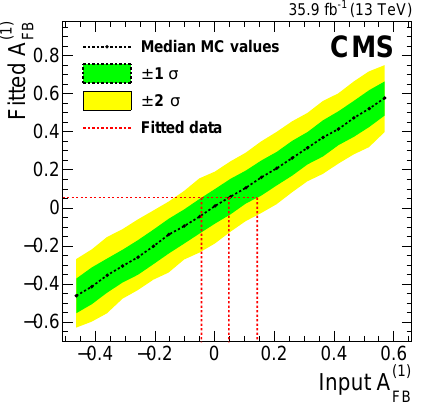
( 1 ) Figure 27. Neyman construction for the A parameter of interest in 1000 pseudo-experiments generated FB with systematic uncertainty nuisance parameters allowed to vary. The horizontal dotted line indicates the value of the parameter determined from the fit and the vertical dotted line indicates where this value intersects with the central value and uncertainty contour from the